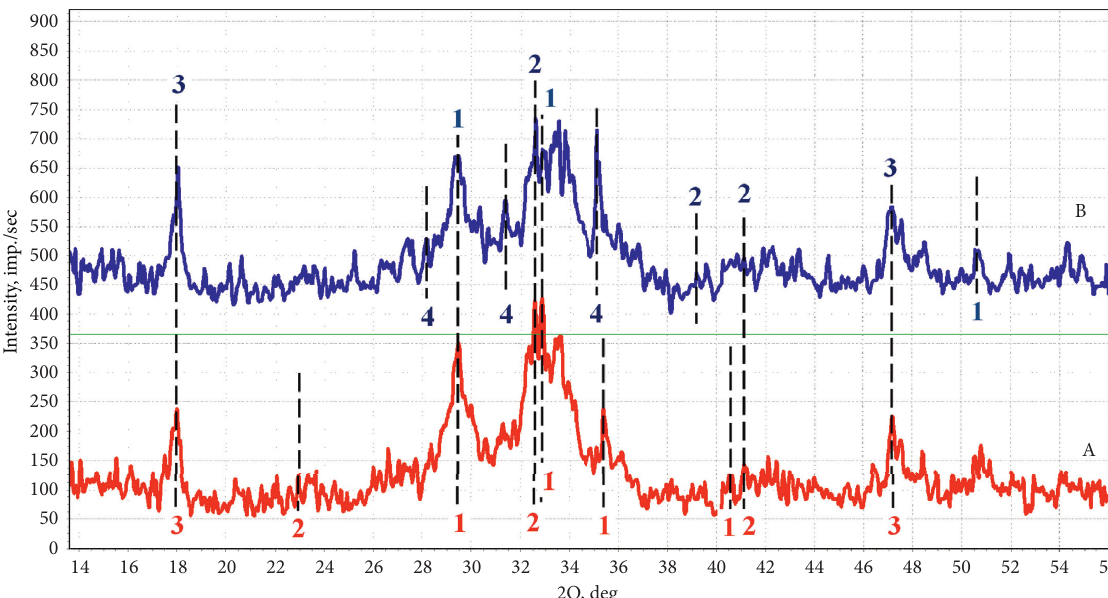
Figure 12: Diffraction patterns of hardened Portland cement paste (A) and cement paste in a composite based on a modified shot of titanium hydride (B), subjected to c -irradiation dose D � 2MGy: 1-2Ca 3 Si 2 O 7 · O 2 P ; 2–Ca 2 SiO 4 ; 3-Ca(OH) 2 ; 4–Ca 2 Si 2 O 5 (OH) 2 · H 2